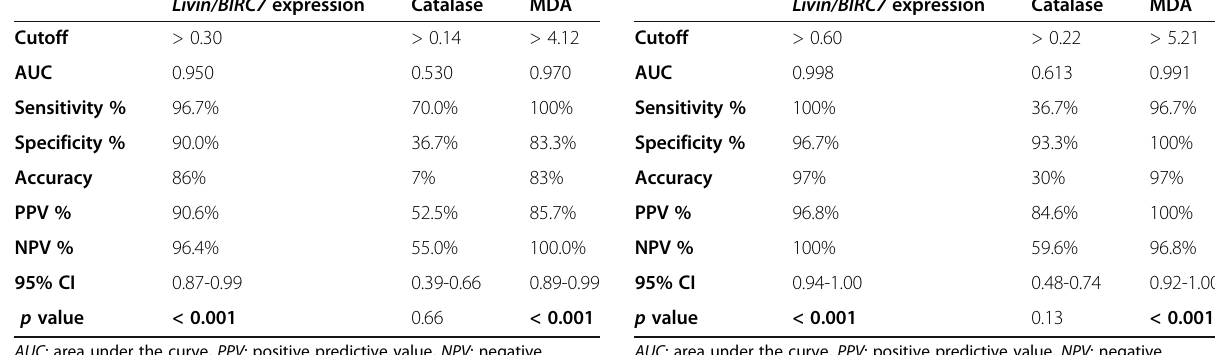
Table 4 Diagnostic performance of livin/BIRC7 expression, catalase, and malondialdehyde (MDA) for prediction of endometrial hyperplasia Livin/BIRC7 expression